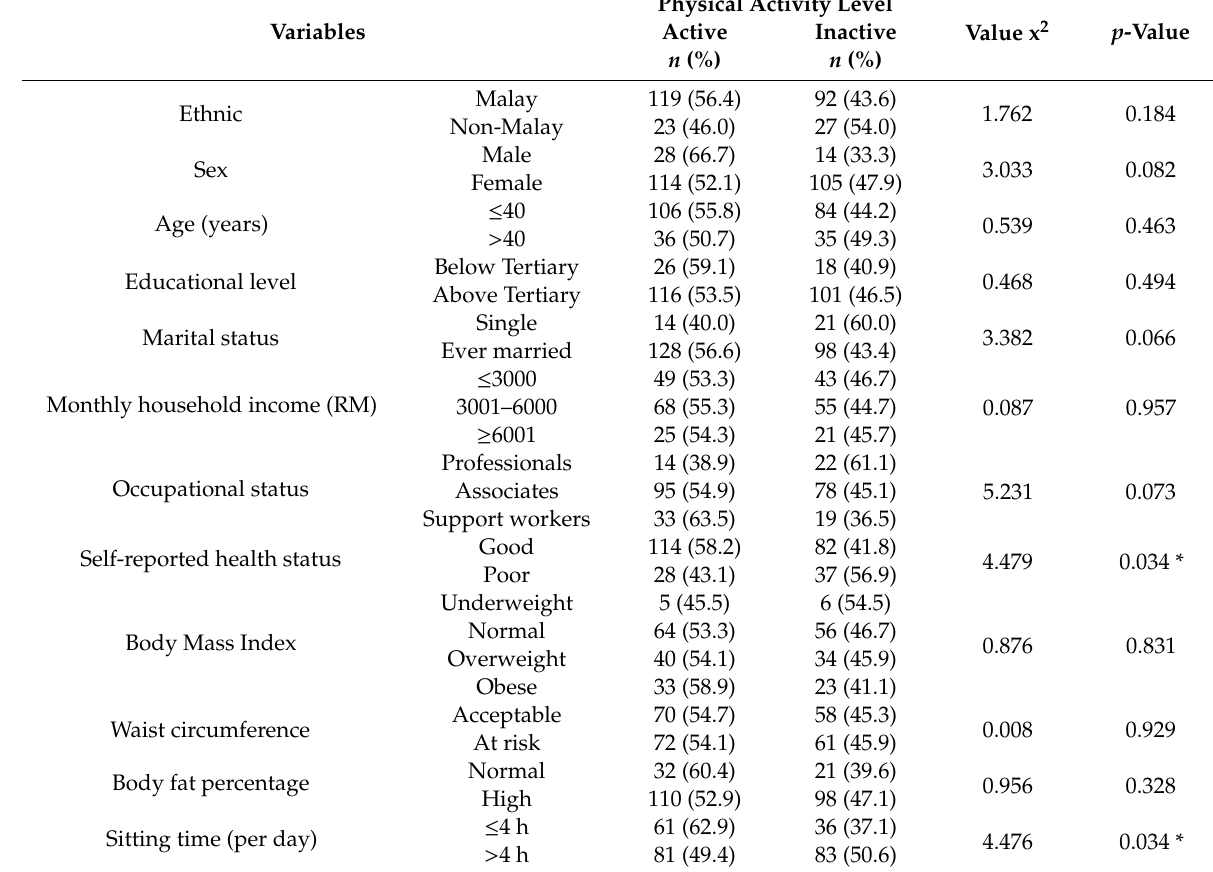
Table 3. Association between various characteristics with physical activity